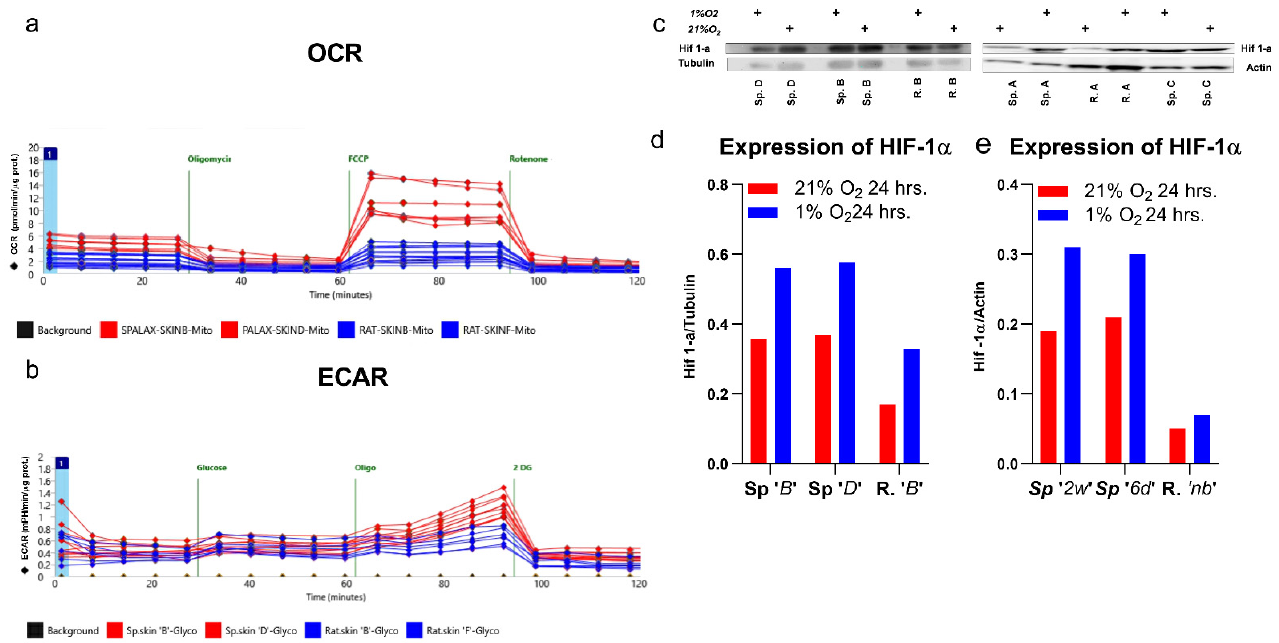
Figure 4. Oxygen consumption rate (OCR) ( a ) and extracellular acidification rate (ECAR) ( b ) in Spalax and rat cells estimated using the Seahorse platform, and expression of HIF-1 α in Spalax and the rat skin cells under normoxia and hypoxia after 24 h of the study. Western blot (WB) of HIF-1 α for Spalax and rat skin FB using antibodies HIF-1 α (28b):sc-13515 (Santa Cruz) ( c ); ( d , e ) densitometrical quantification of HIF-1 α expression normalized to tubulin and actin, respectively. SKNB, skin newborn ‘B’; SKND, skin newborn ‘D’; RAT-SKINB, rat skin ‘B’; RAT-SKINF, rat skin ‘F’.